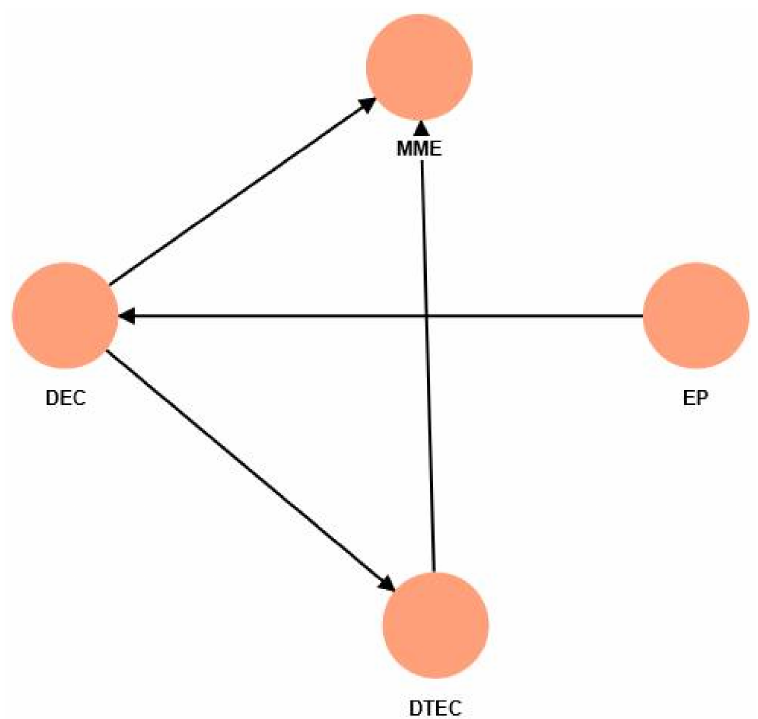
Figure 1 reflects the relationship between our variables.